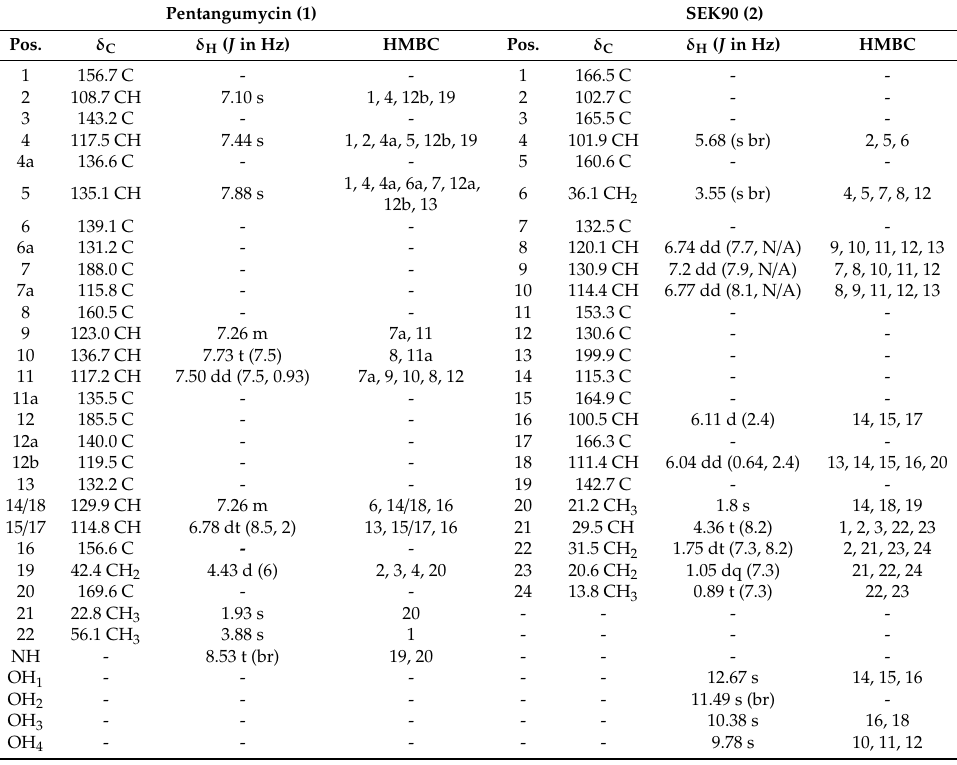
Table 1. NMR spectroscopic data for pentangumycin ( 1 ) (DMSO-d 6 ) and SEK90 ( 2 ) (DMSO-d 6